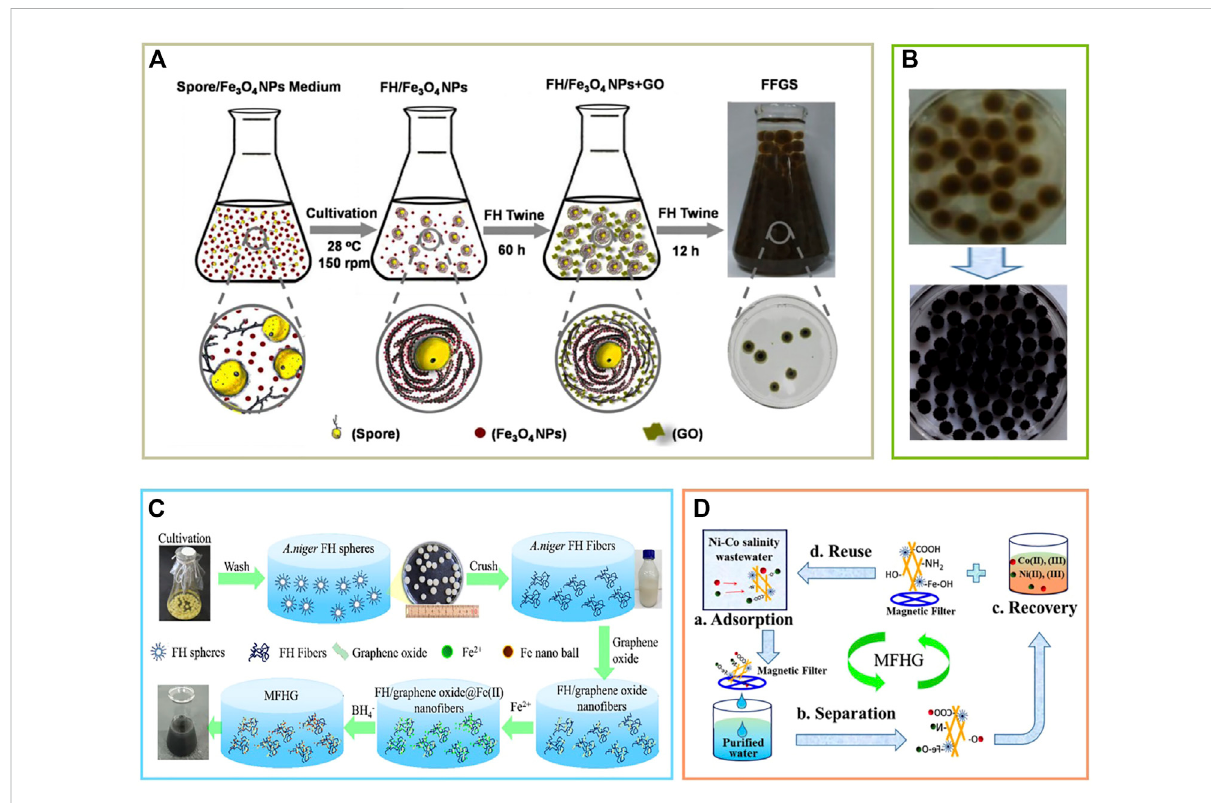
FIGURE 5 (A) Synthesis of layered core-shell structured fungus hyphae (FH)/Fe 3 O 4 /graphene oxide (GO) nanocomposite spheres (FFGS), (B) removal and recovery of methyl violet (MV) and uranium (U) (after 72 h) (Zhu et al., 2019), (C) preparation of three-dimensional magnetic fungal